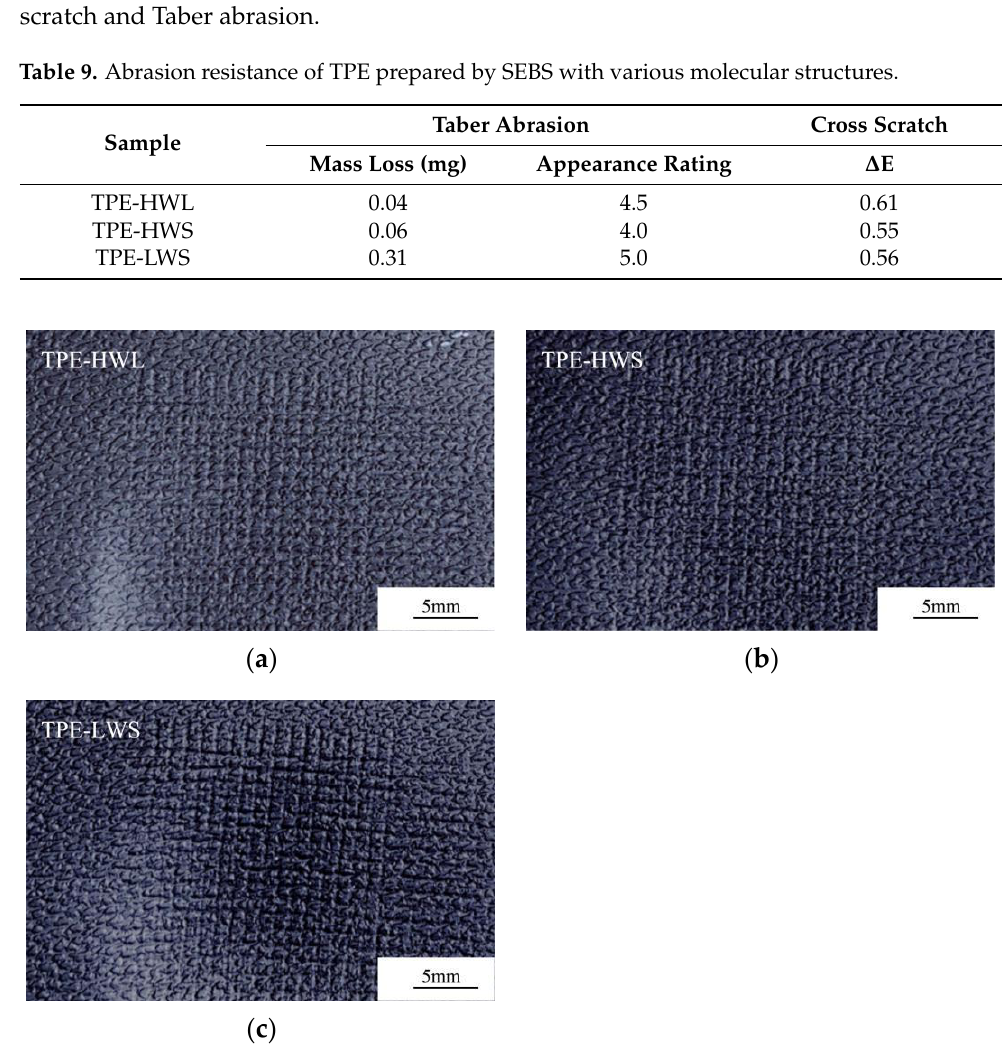
Table 8. Formula design of TPE prepared by SEBS with various molecular chain structures.